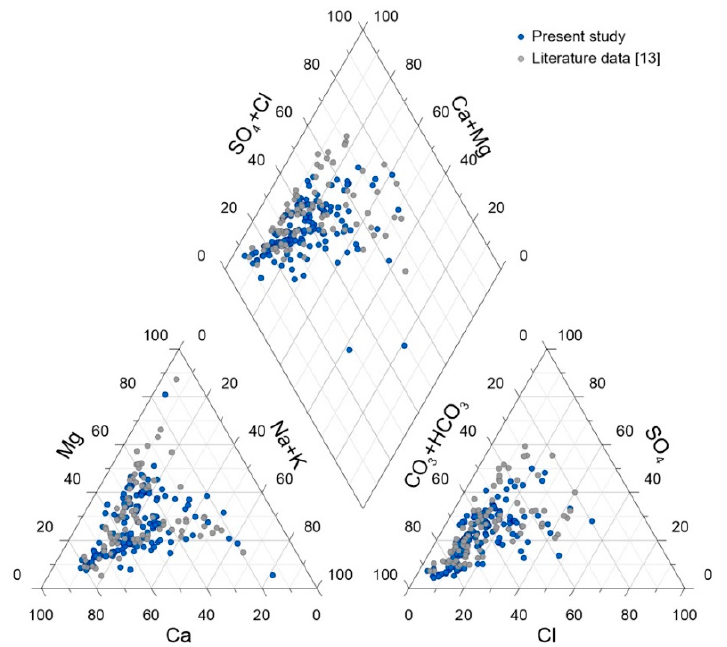
Figure 2. Piper diagram reporting the chemical data of groundwater of present study (blue circles) and literature study (grey circles [13]).